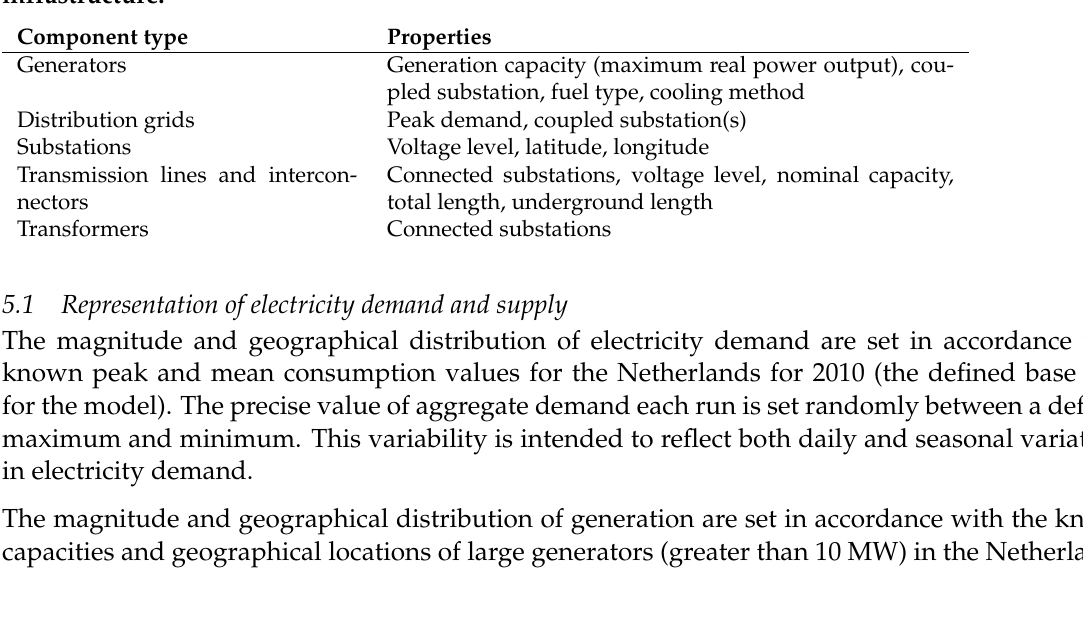
Table 1. Key properties of elements represented in the input dataset describing the Dutch electricity